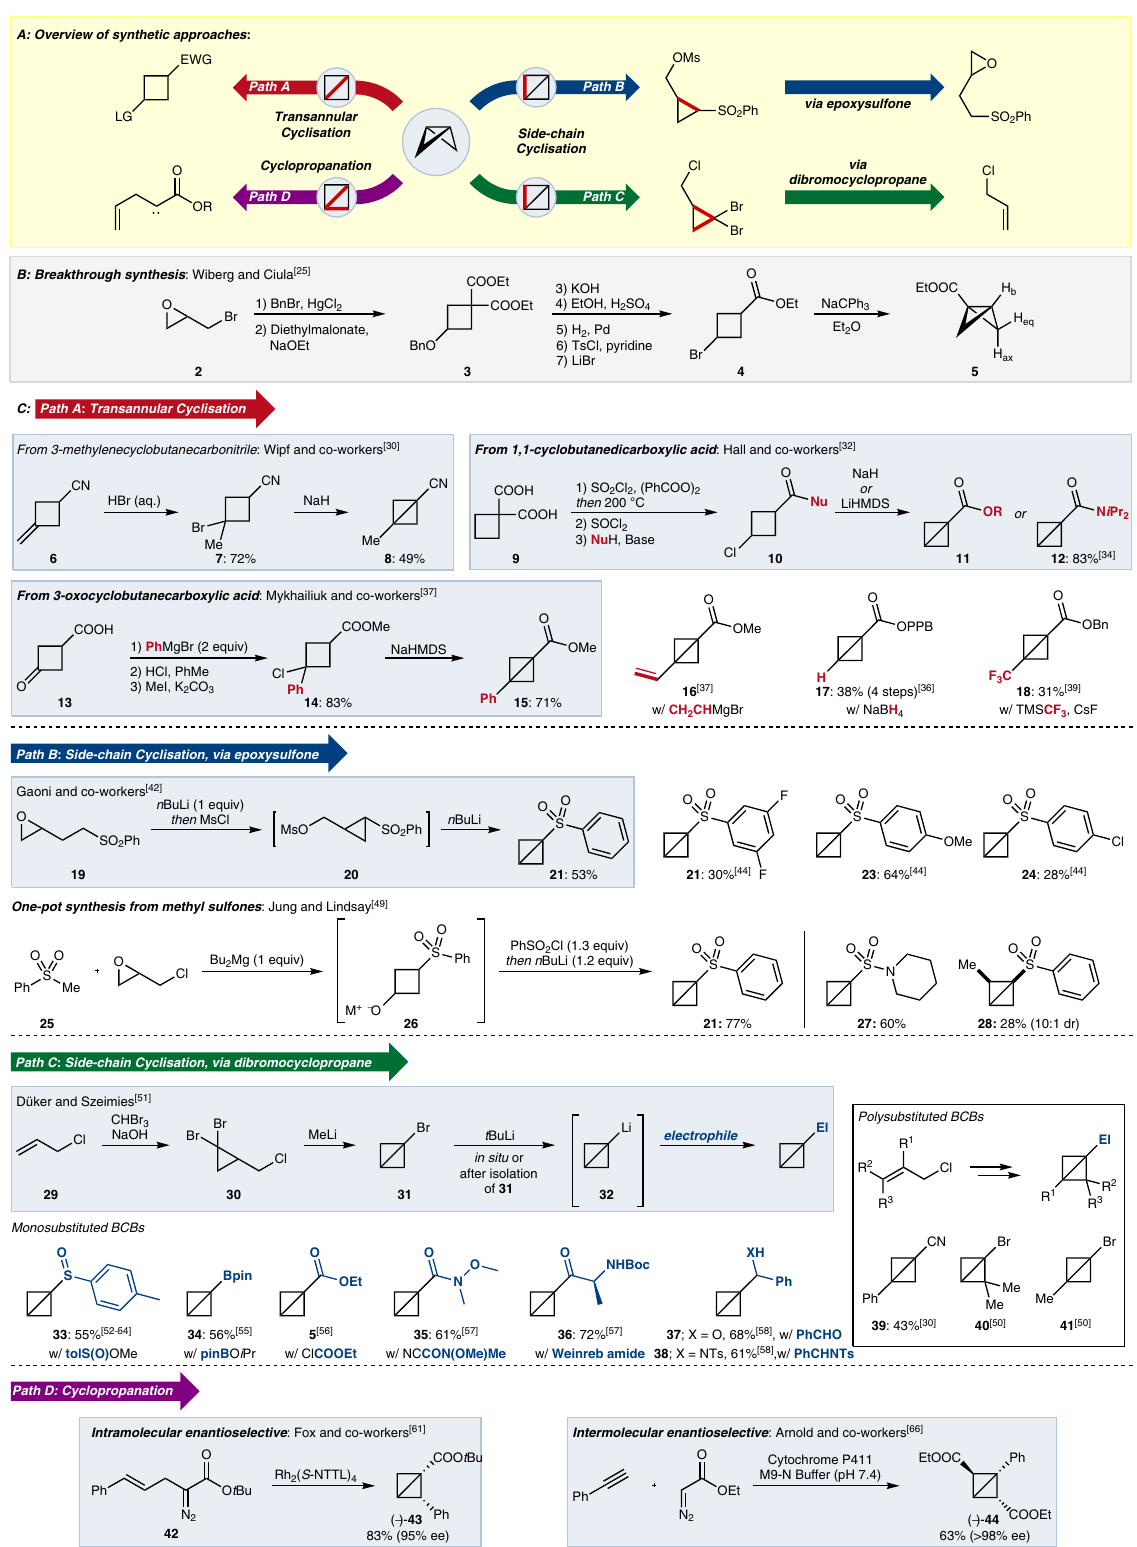
Fig. 2 Overview of synthetic approaches of BCBs. A Overview of the different synthetic approaches to bicyclobutanes categorised by the bonds formed. B The landmark fi rst synthesis of a bicyclobutane derivative by Wiberg and Ciula. C The most commonly used synthetic routes to bicyclobutanes, highlighting the derivatives that can be formed with each route with a focus on the substitution pattern and functional groups that can be incorporated. HMDS bis(trimethylsilyl)amide, TMS trimethylsilyl, Ms methane sulfonyl, tol tolyl, pin pinacol, Ts para -toluene sulfonyl, NTTL N -1,8- naphthaloyl-( S )- tert -leucine; Boc tert -butoxycarbonyl, EWG electron-withdrawing group, LG leaving group, Nu nucleophile, El electrophile.